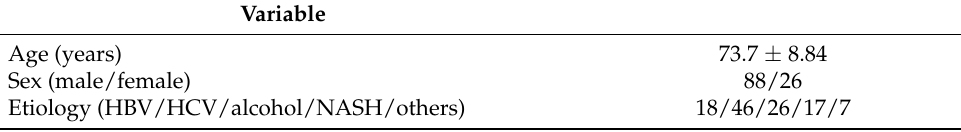
Table 1. Patients’ characteristics.